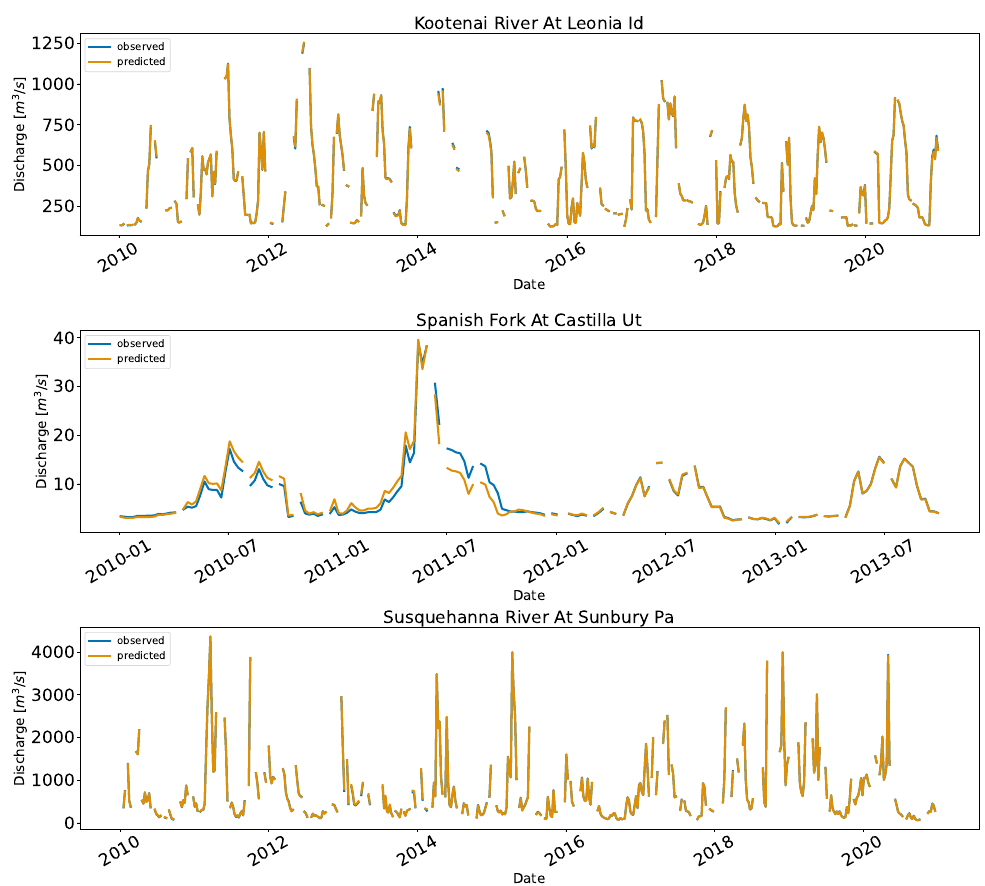
Figure A2. Predicted and observed discharge for the US. For visualization purposes, the data are downsampled into a weekly bin, and the mean values of the discharge failing into the bins for the station are shown.